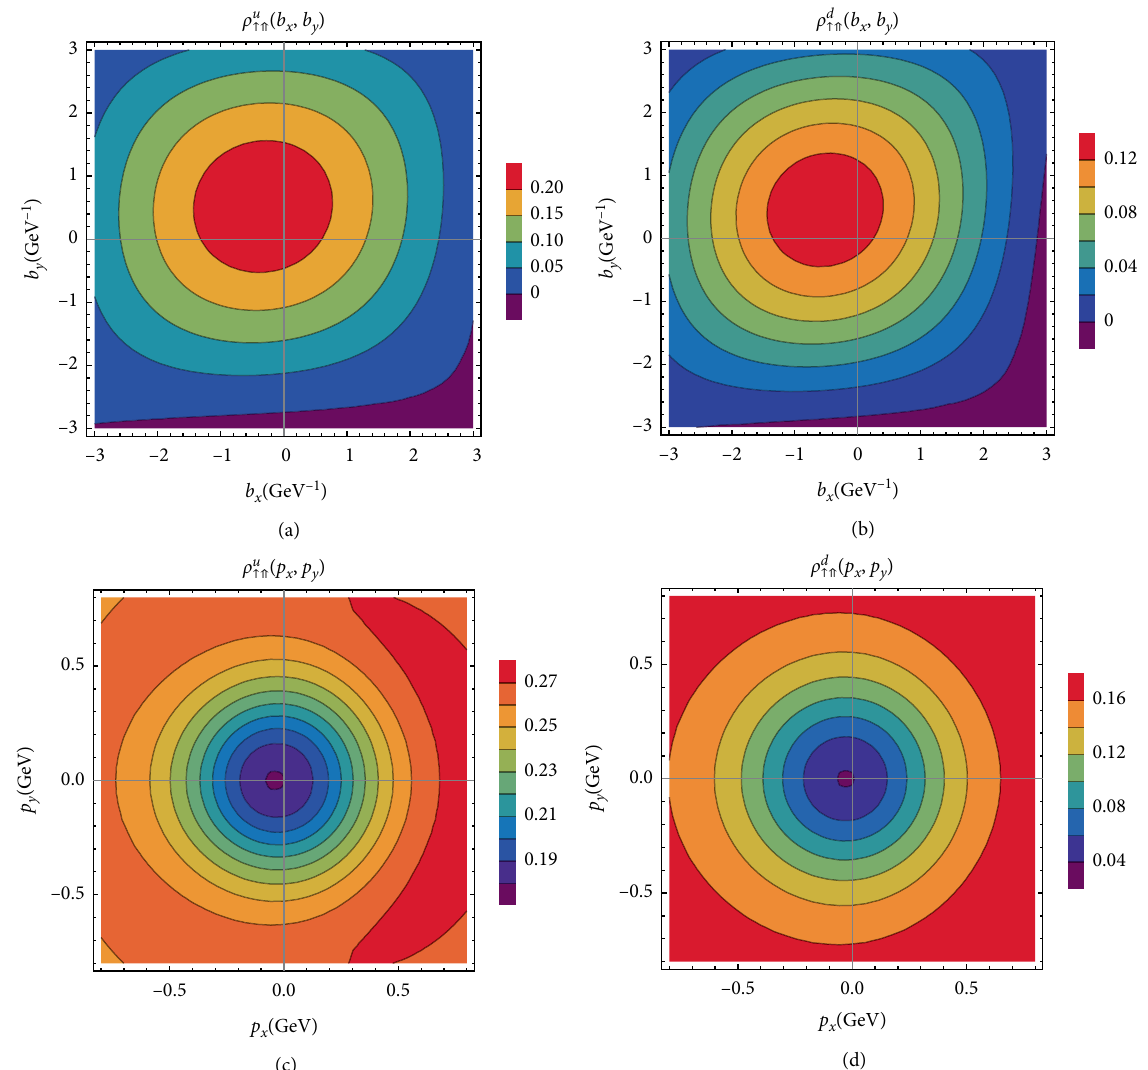
( b , p ) in transverse impact-parameter plane and transverse momentum plane for 𝑢 -quark ↑⇑ ⊥ ⊥